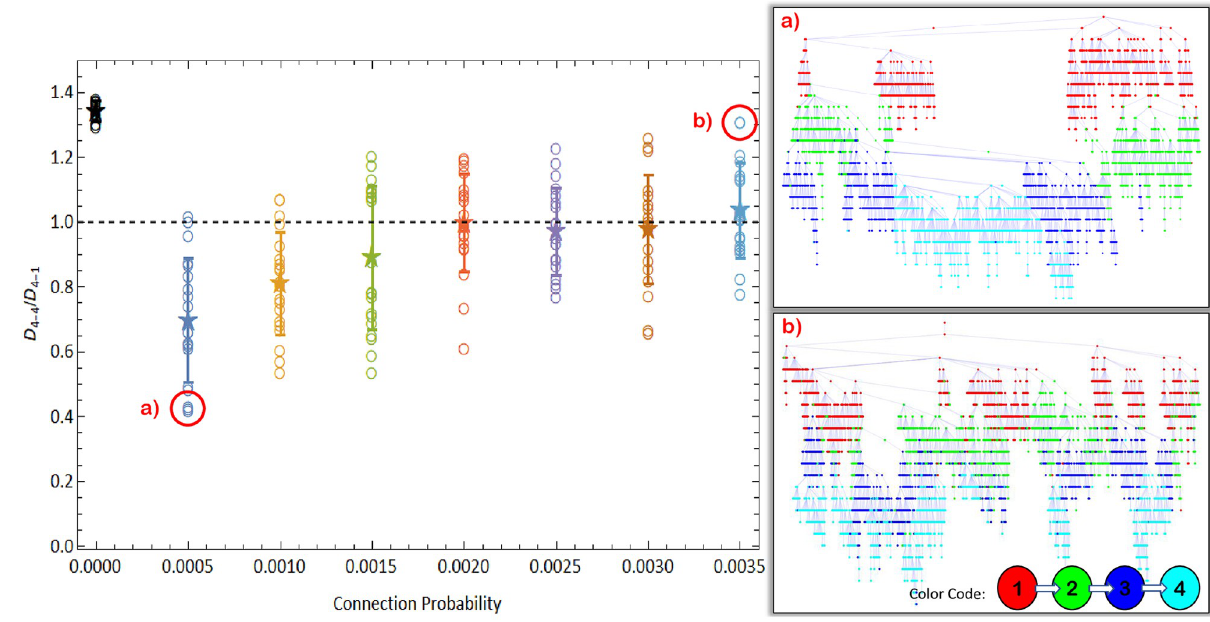
Fig 7. Ratio between the average distance in city 4 and the average distance between cities 1 and 4. Right panels show infection trees for the simulations highlighted with red circles. Open circles show results for individual simulations, the star is the average over 20 simulations and error bars are standard deviations. p = 0 represents a single Barabasi-Albert network with 4000 nodes (see text). Nodes in infection trees represent infected individuals, colored according to its city. City 4 (cyan) in panel (a), where D 4 − 4 / D 4 − 1 < 1, was almost entirely infected by a single viral lineage, while in / D 4 > 1, it was infected by many different viral panel (b) where D 4 − 4 − 1